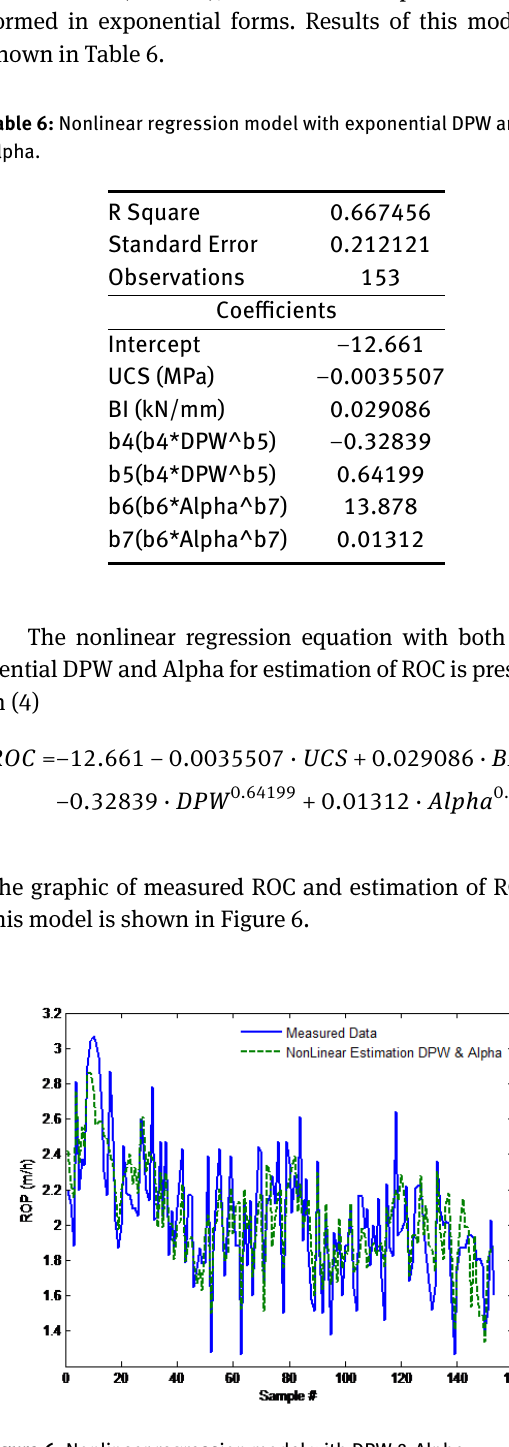
newnonlinearregressionmodelwillbedevelopedforboth